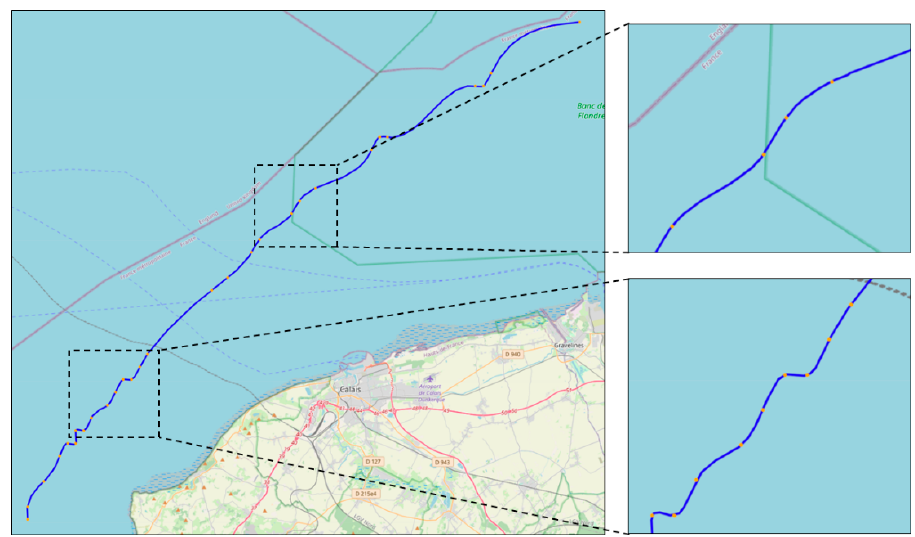
Figure 14. Comparison of denoising effects of MMSI 220002000. ( a ) Data preprocessing; ( b ) data cleaning; ( c ) trajectory reconstruction.